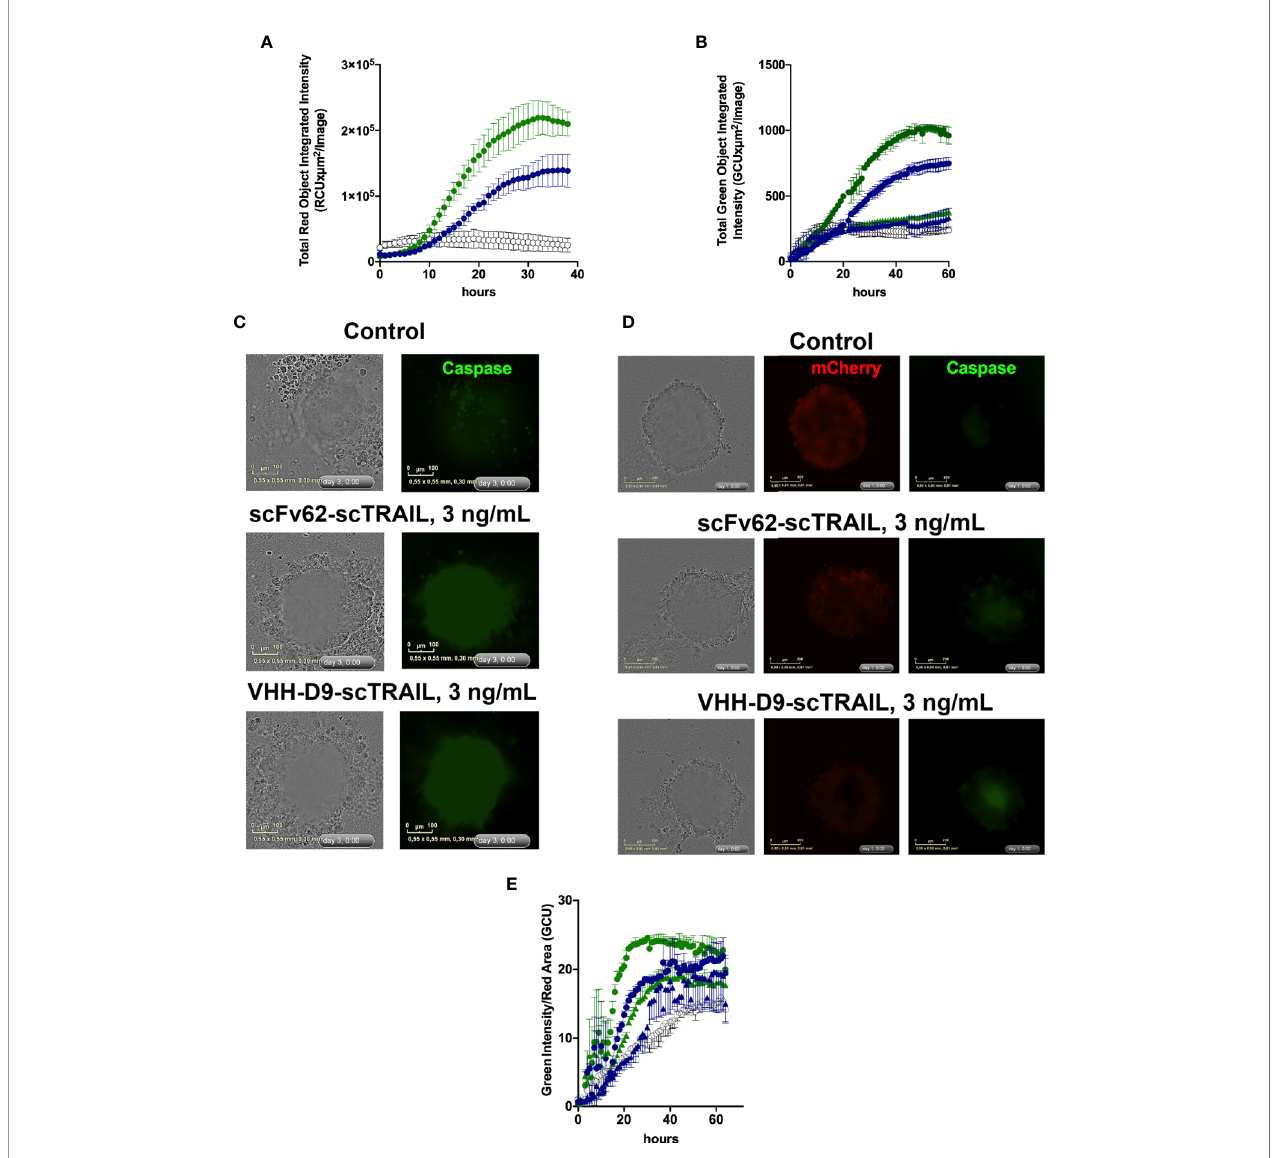
FIGURE 6 | Apoptosis induction by scFv62-scTRAIL and VHH-D9-scTRAIL on Capan-1 cells. (A) Cells seeded in 96 well plates were treated with 3 ng/ml of scFv62-scTRAIL (35 pM, blue) or VHH-D9-scTRAIL (42 pM, green), and apoptosis was measured over time using a green fl uorescent caspase reporter. VHH-D9- scTRAIL produced a larger fraction of apoptotic cells. (B) Apoptosis induction in Capan-1 spheroids of 0.3 ng/ml (triangles) or 3 ng/ml (circles) VHH-D9-scTRAIL (green) or scFv62-scTRAIL. The effects were similar to those observed in two-dimensional (2-D) culture, albeit delayed in time. (C) Representative images of spheroids produced by Capan-1 cells and treated as indicated. Green fl uorescence indicates caspase 3/7 activation. (D) Representative images of spheroids produced by Capan-1 cells co-cultured with stellate cells and treated as indicated. Red fl uorescence identi fi es stellate cells (mCherry), while green corresponds to caspase activation. (E) Apoptosis induction in Capan-1 spheroids cocultured with RLT-PSCs expressing mCherry relative to the size of the compact spheroid. Apoptosis was detected as green fl uorescence, and the size of the compact spheroid was inferred from the area of red fl uorescence from stellate cells. There was fast and intense induction of apoptosis when 3 ng/ml (circles) VHH-D9-scTRAIL (green) or scFv62-scTRAIL were added to the medium. 0.3 ng/ml (triangles) showed little apoptosis induction. All data presented as means ±